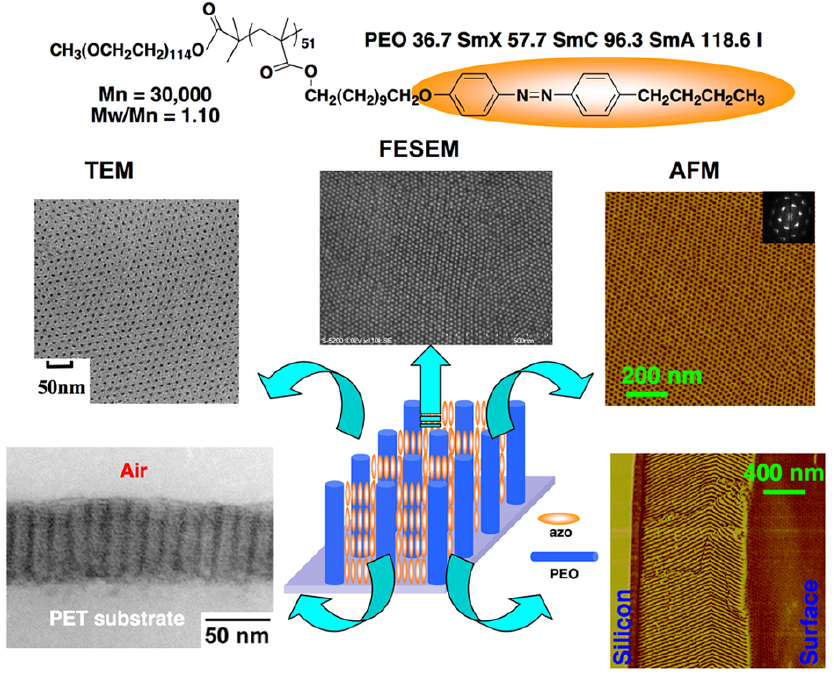
Figure 13. Perpendicular array of nanocylinders and photoresponsive mesogens in a PRBC film by thermal